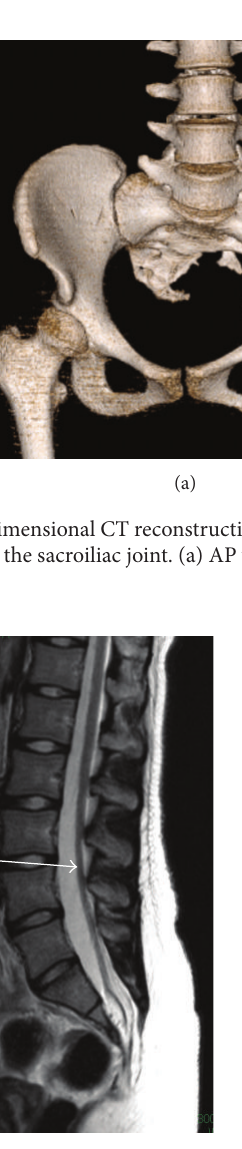
Figure3:SagittalT2-weightedmagneticresonanceimagingshowed atetheringcord(whitearrow).Thetransitionbetweentheconusand filum was not